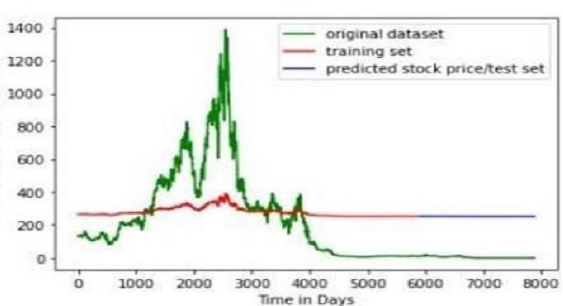
Fig 15. LSTM Prediction with training set and testing set